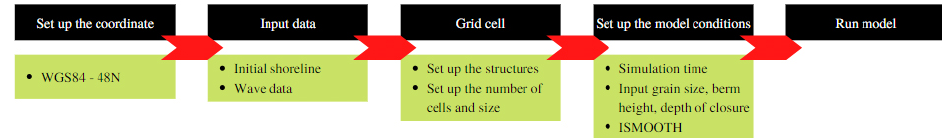
9 of 23 Figure 8. Comparison between ( a ) simulated and observed water levels at TGR1 and TGR2 stations, ( b ) wave heights at SMS station. •